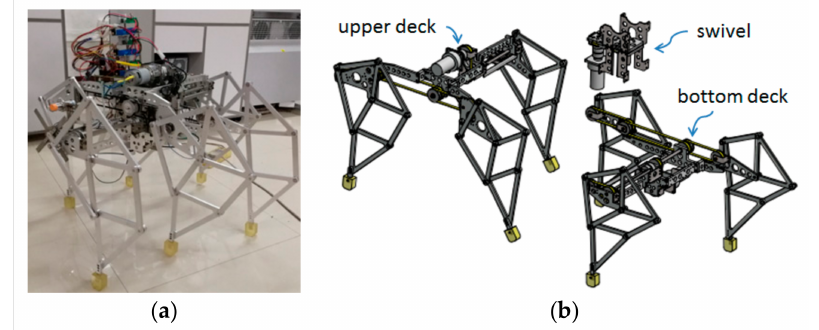
Figure 2. ( a ) Completed hexapod robot. ( b ) Three major